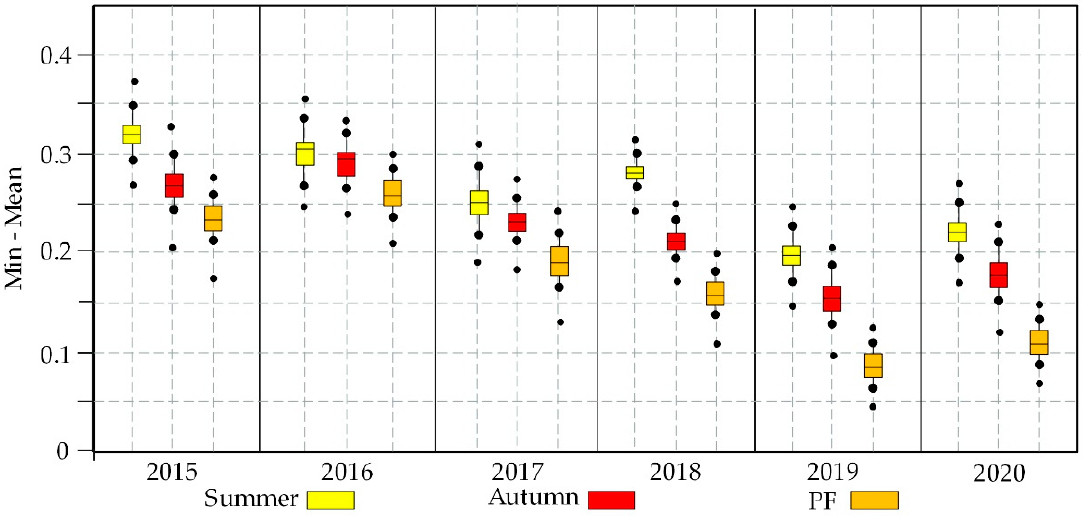
Figure 4. Analysis of days for the severity of the fire using NDVI. 3.2. NBR Table 4. Data for each polygon used in NBR